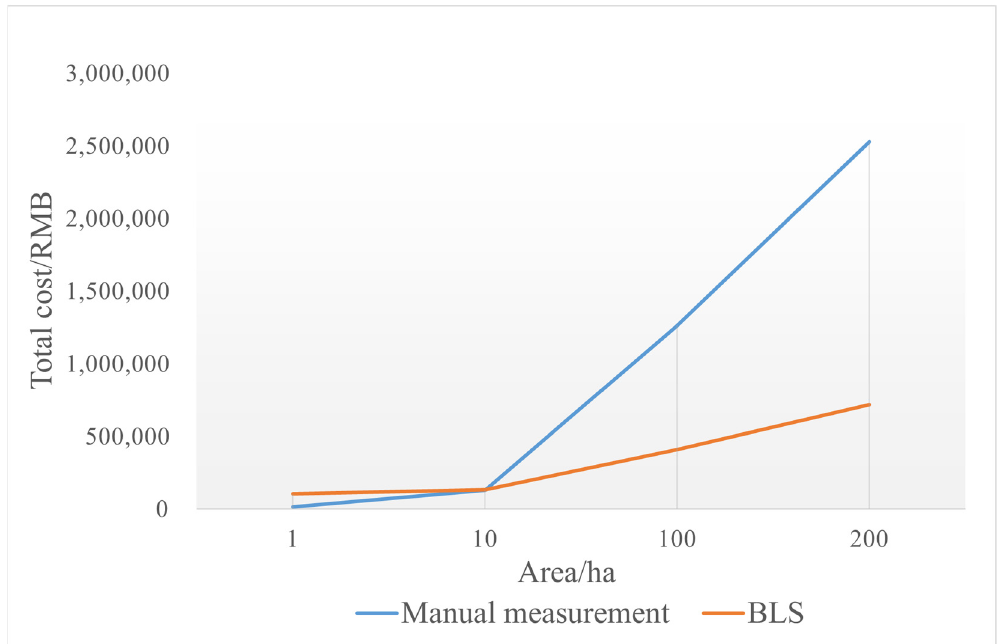
Figure 9. Cost–benefit analysis diagram of manual measurement methods versus BLS survey meth- ods.